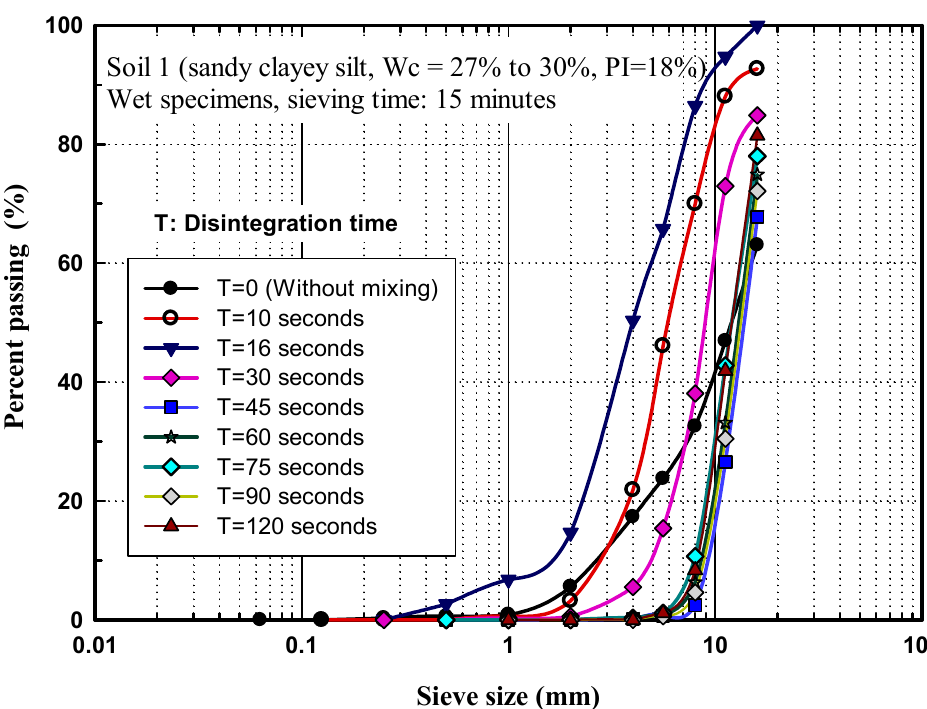
Figure 8. Percentage passing through versus sieve size for wet specimens of Soil 1 prepared at different disintegration times.